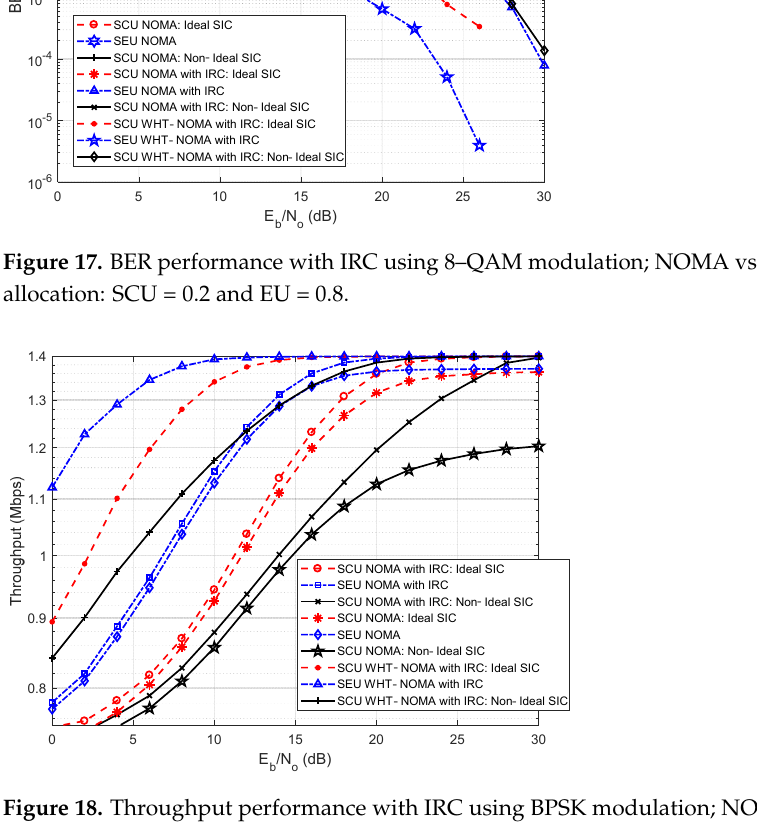
power allocation: SCU = 0.2 and SEU = 0.8.